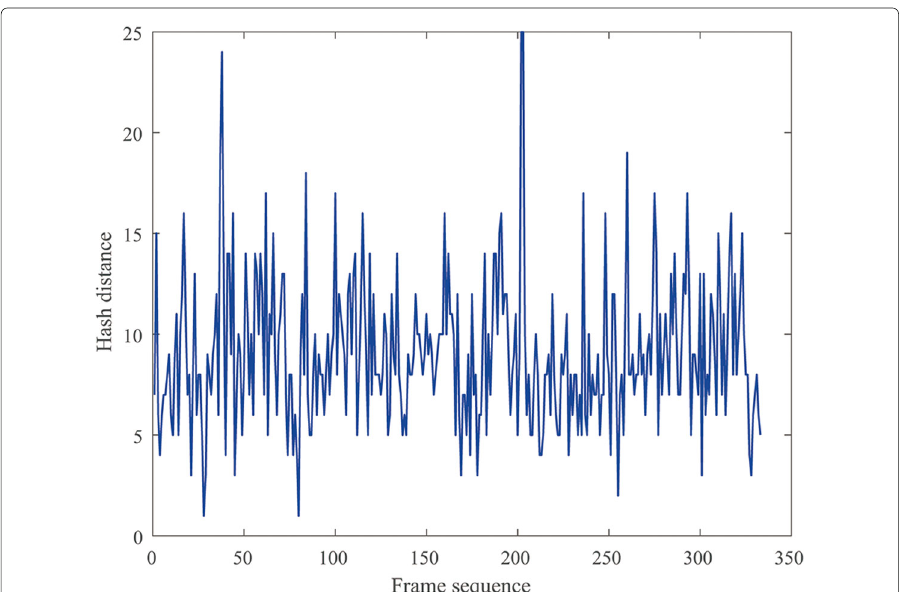
Fig. 3 Hash distance between target regions of adjacent frames in BlurBody video